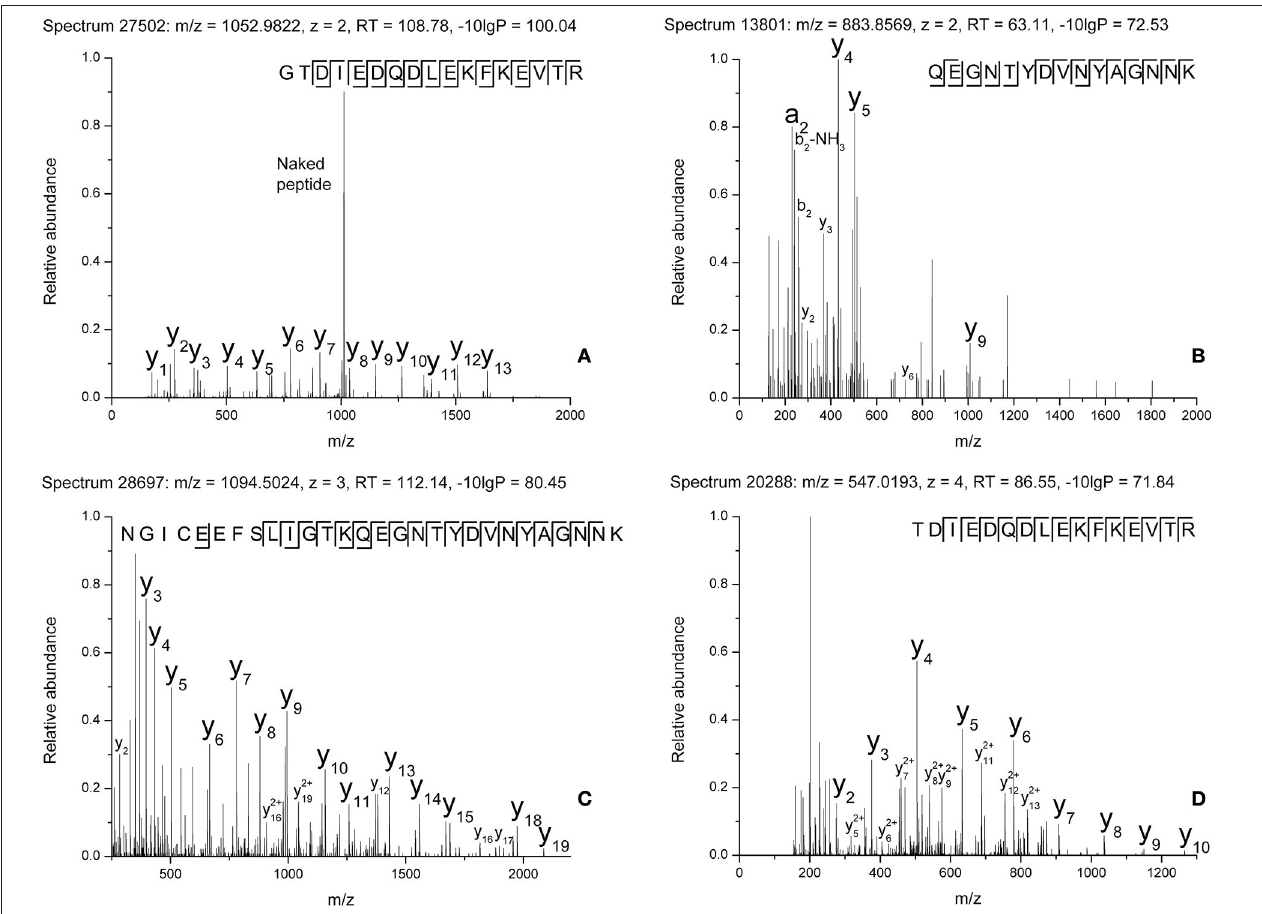
FIGURE 5 | MS/MS spectra of modified peptides and the relevant fragments for their attribution. (A) Spectrum n ◦ 27502. (B) Spectrum n ◦ 13801. (C) Spectrum n ◦ 28697. (D) Spectrum n ◦ 20288.